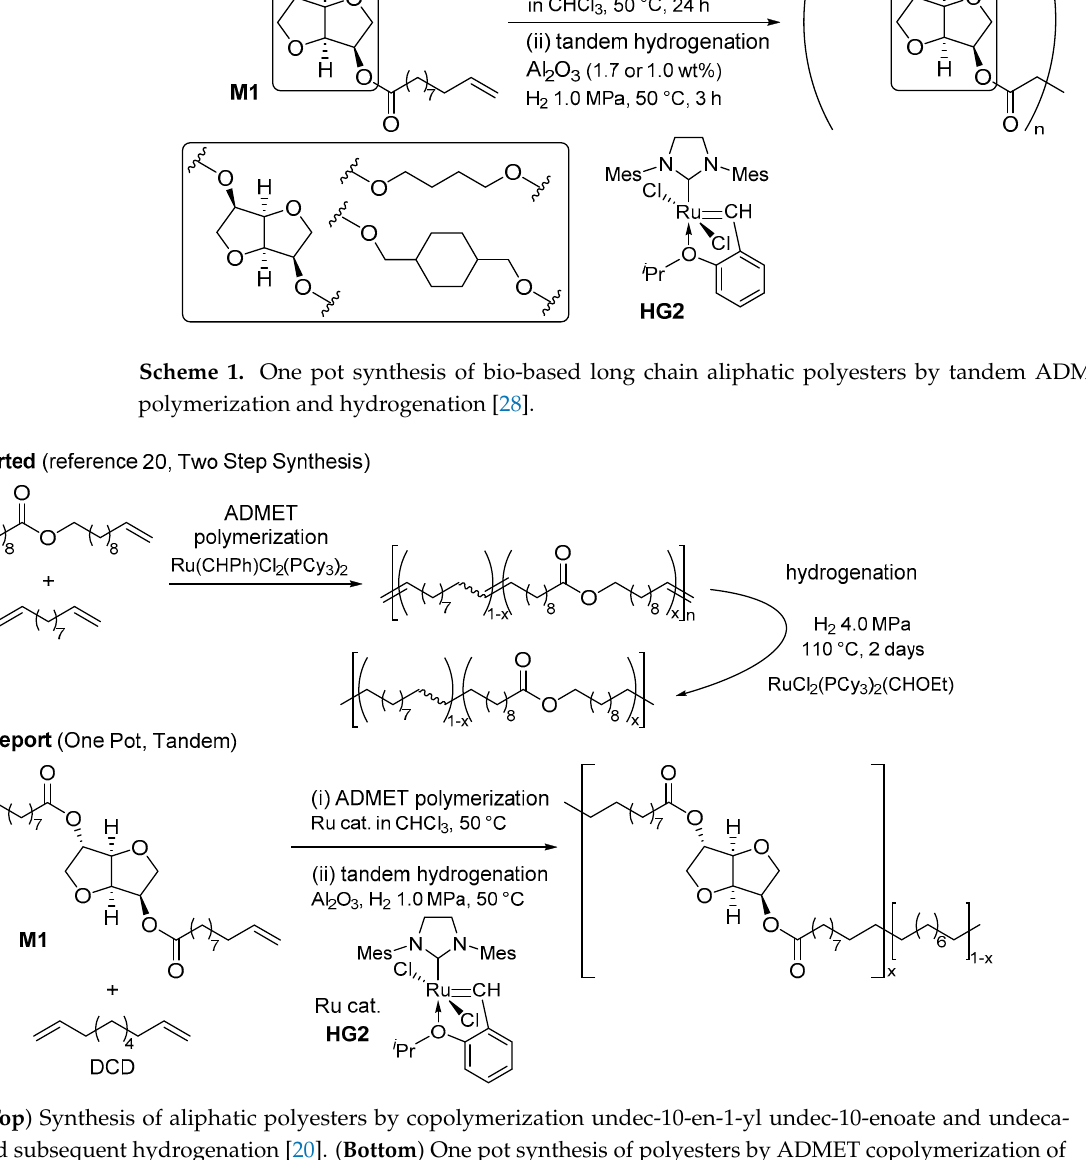
Scheme 1. One pot synthesis of bio ‐ based long chain aliphatic polyesters by tandem ADMET polymerization and hydrogenation